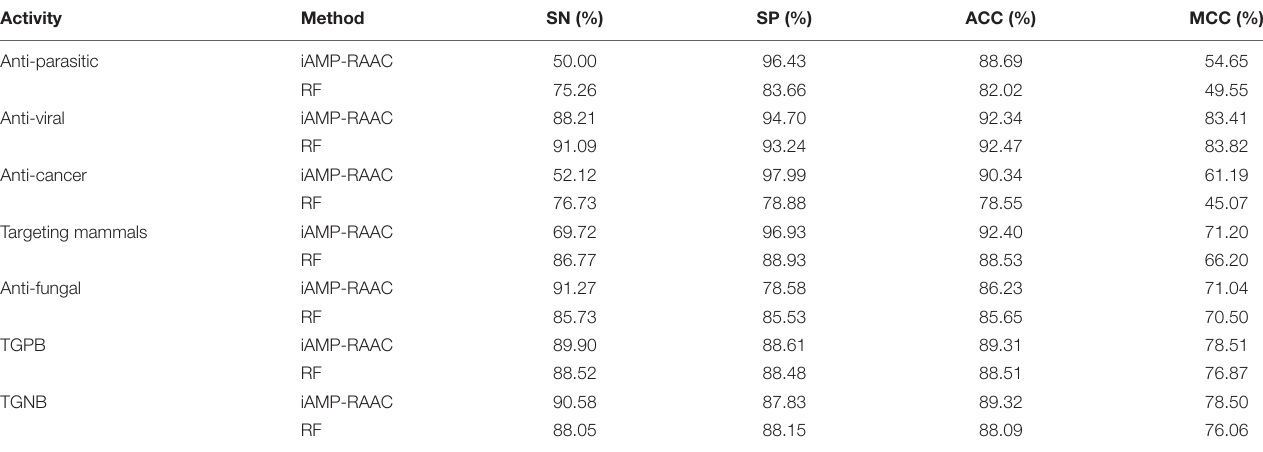
TABLE 5 | Performance comparisons of iAMP-RAAC and RF (Chung et al., 2019) on training set in DS2 in the seven different AMP functional activities based on 10-fold cross-validation. Activity